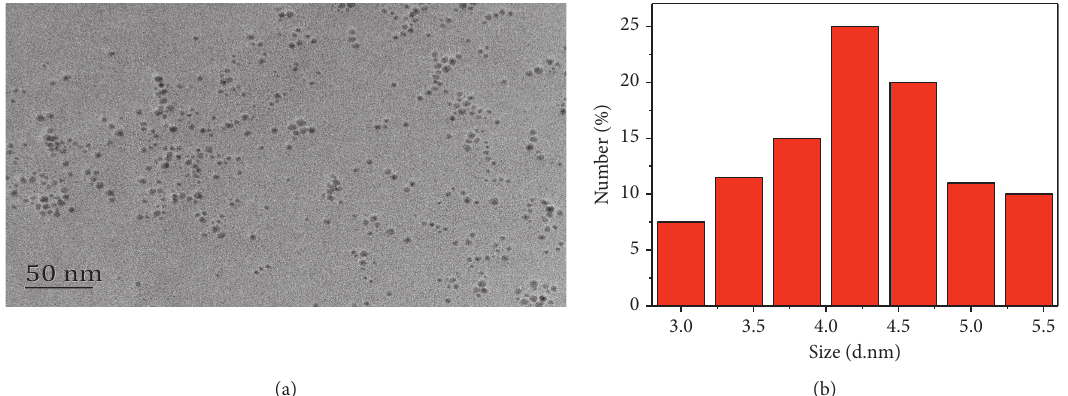
Figure 1: (a) TEM images of the Ag NCs. (b) The particle size distribution histogram of the Ag NCs.